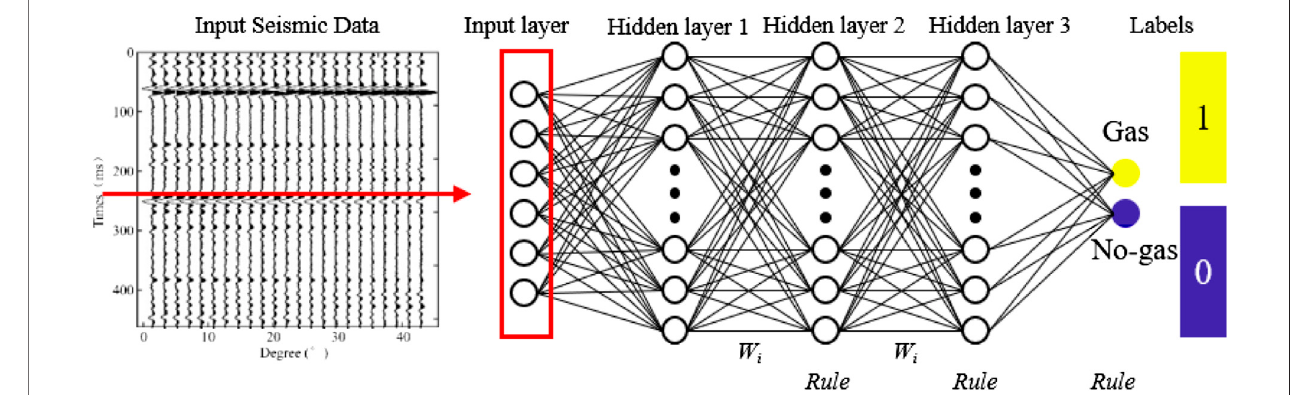
FIGURE 6 | DNN network structure.